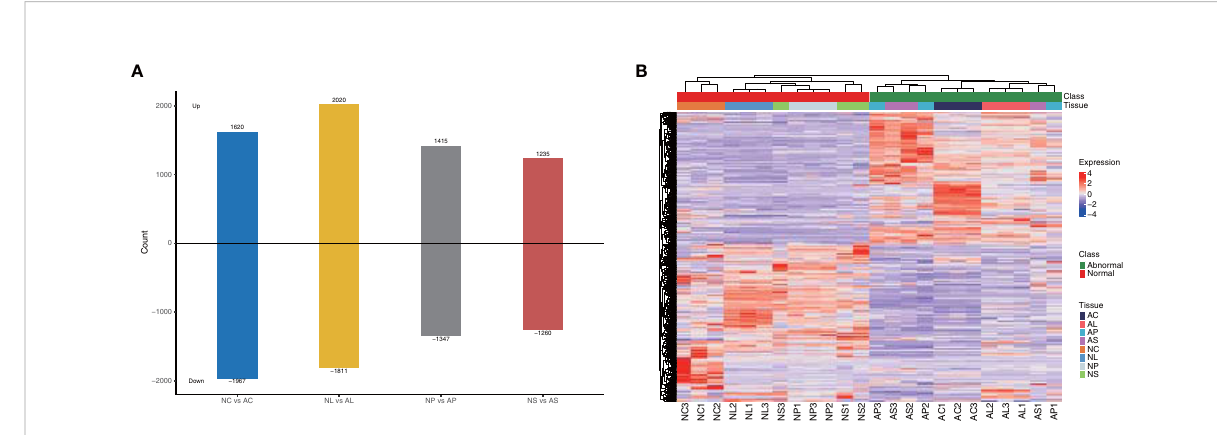
FIGURE 3 DEGs between different comparisons. (A) The number of up-regulated and down-regulated genes between NC vs AC, NL vs AL, NP vs AP, NS vs AS. (B) Heatmap of DEGs, scaled by rows.